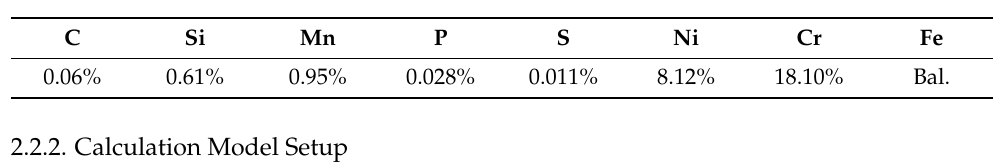
Table 1. Chemical composition of the